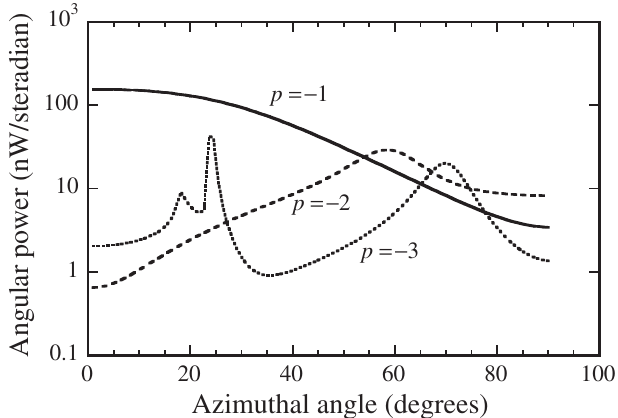
FIG. 6. Total incoherent power radiated on the first, second, and third orders (dotted lines) and total superradiant power radiated on the second, third, and fourth harmonics (solid lines).